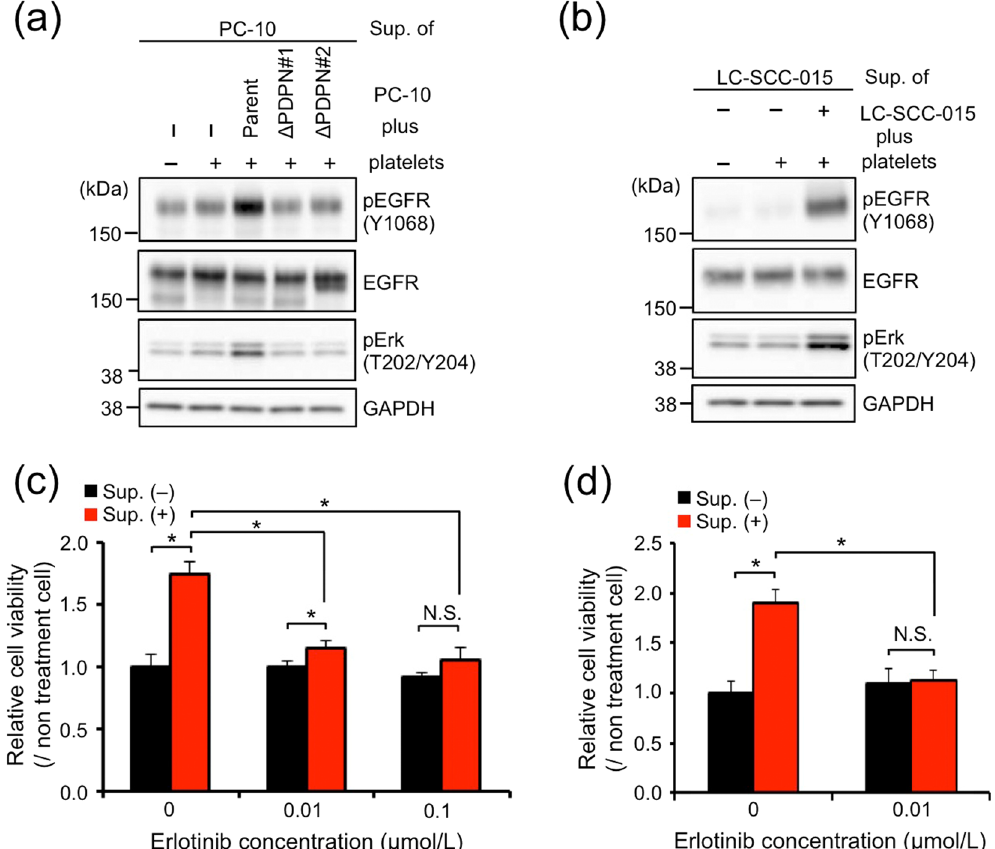
Figure 4. Supernatant of a PC-10-platelet reactant activated EGFR signal. ( a ) PC-10 (parent) cells starved for 24 hours were treated for 2.5 minutes at 37 °C with supernatant collected from platelets alone or platelets plus PC-10, PC-10 Δ PDPN#1, or PC-10 Δ PDPN#2 cells. After ice-cold PBS wash, the cells were lysed with SDS lysis buffer, and Western blot analysis was performed. ( b ) SCC-015 cells starved for 24 hours were treated for 2.5 minutes in 37 °C with supernatant collected from platelets alone or platelets plus SCC-015 cells. After ice- cold PBS wash, the cells were lysed with SDS lysis buffer, and Western blot analysis was performed. Multiple exposure images of full-length blots were presented in Supplementary Fig. S8. ( c ) PC-10/ZsG cells were incubated with erlotinib at the indicated concentration. After incubation for 30 minutes, PC-10/ZsG cells were treated with the supernatant of a PC-10 (parent)-platelet reactant and incubated for 72 hours under 0.5% FBS condition, followed by measuring ZsGreen fluorescence as cell viability. All data are shown as means ± SD of triplicate experiments. * P < 0.05 by Mann–Whitney U -test. N.S., Not significant. ( d ) SCC-015 cells were incubated with erlotinib at the indicated concentration. After incubation for 30 minutes, SCC-015 cells were treated with the supernatant of a SCC-015-platelet reactant and incubated for 72 hours under 0.5% FBS condition. Cell viability was detected by Cell Proliferation ELISA, BrdU. All data are shown as means ± SD of triplicate experiments. * P < 0.05 by Mann–Whitney U -test. N.S.: Not